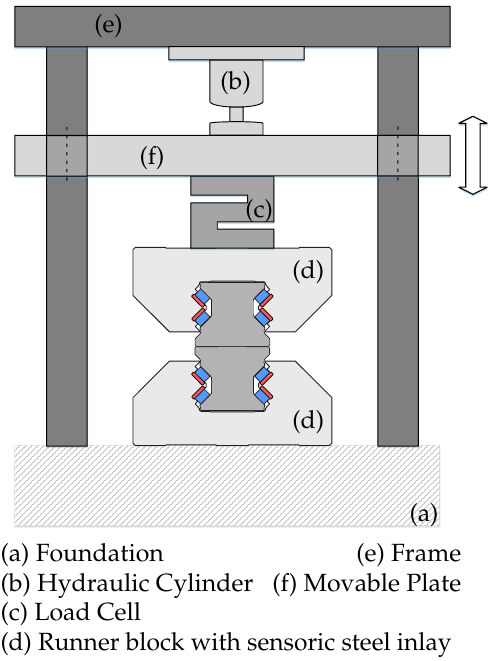
Figure 5. Sketch of the mechanical measurement setup. Runner block graphic from [17].